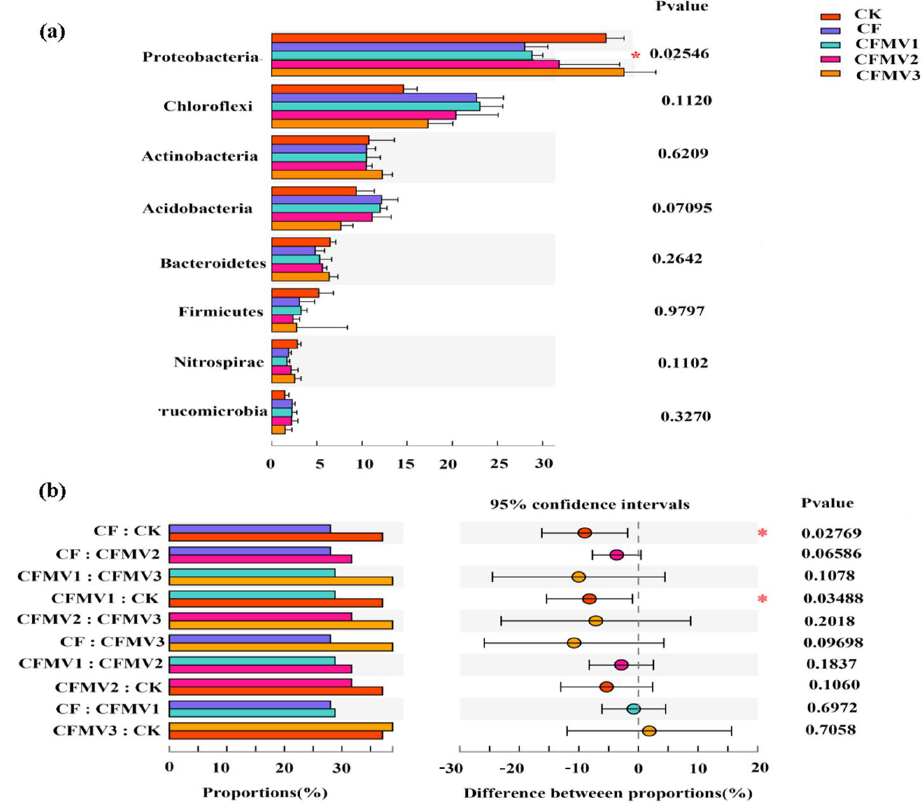
Figure 3. Relative abundances ( a ) and bar plot on phylum level ( b ) of bacterial phyla in the paddy soil. CK, no chemical fertilizers and no CMV; CF, chemical fertilizers; CFMV1, chemical fertilizers + 11,250 kg ha − 1 CMV; CFMV2, chemical fertilizers + 22,500 kg ha − 1 CMV; and CFMV3, chemical fertilizers + 45,000 kg ha − 1 CMV. (“*” showed significant differences in 0.01 < p ≤ 0.05).